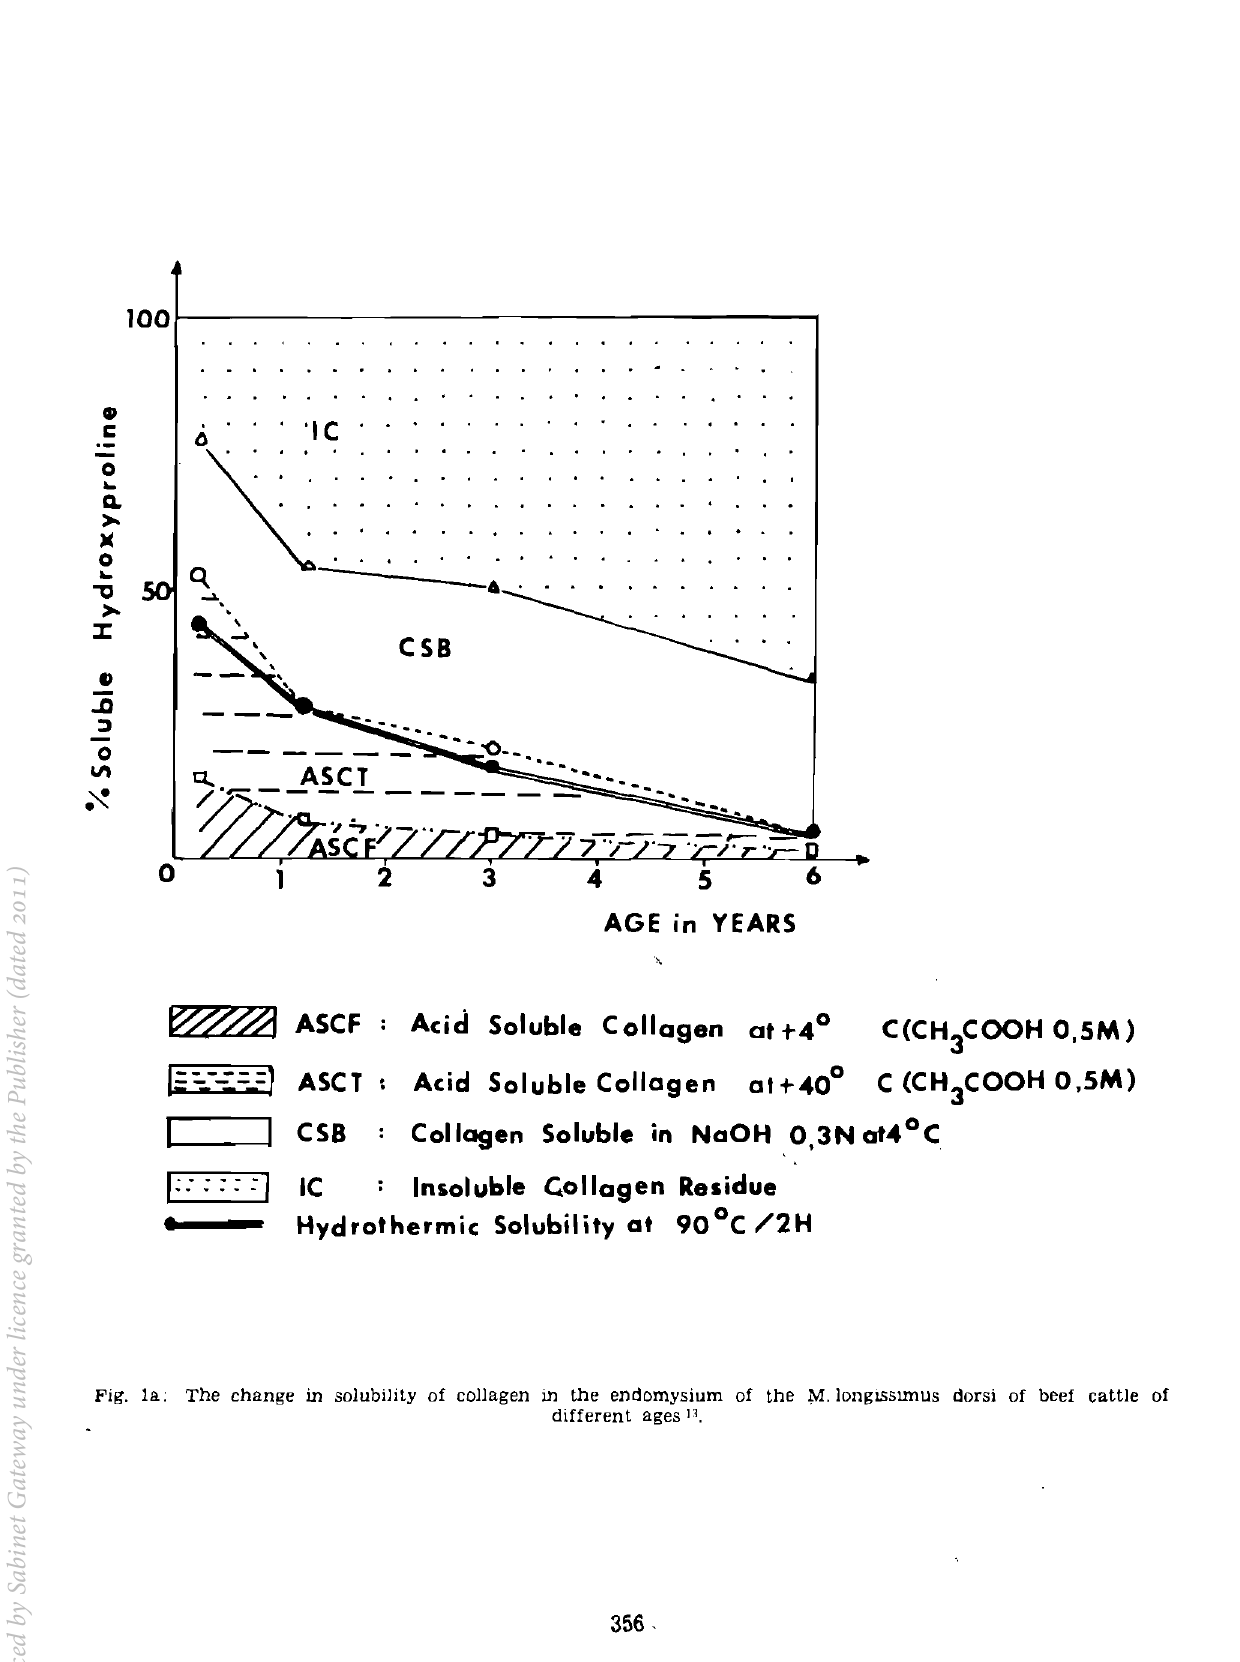
Fig, la: The change in solubility of collagen in the endomysium of the ~,longissunus dorsi of beef cattle of different ages 13,